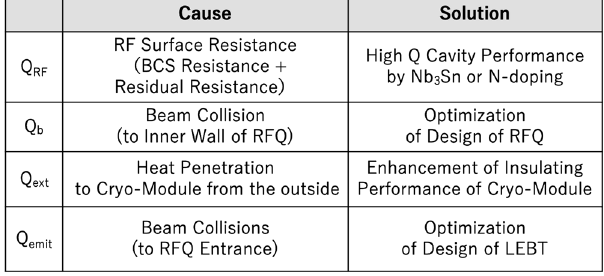
FIG. 3. The classification of amount of heat generated in a cryomodule [10,11].